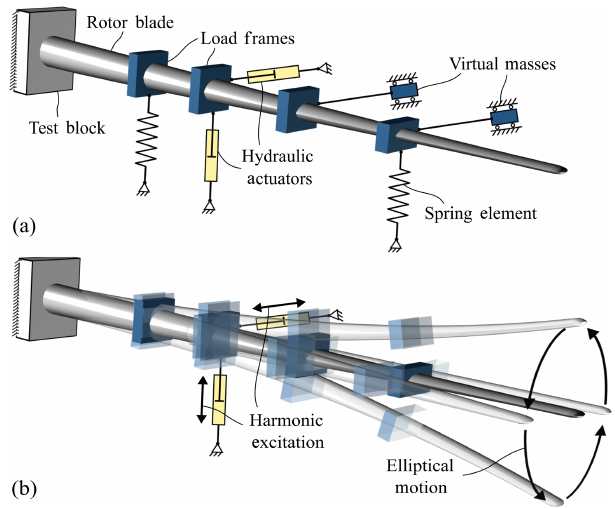
Figure 1. Biaxial fatigue test: (a) schematic of test setup and (b) el- liptical resonant excitation and resulting